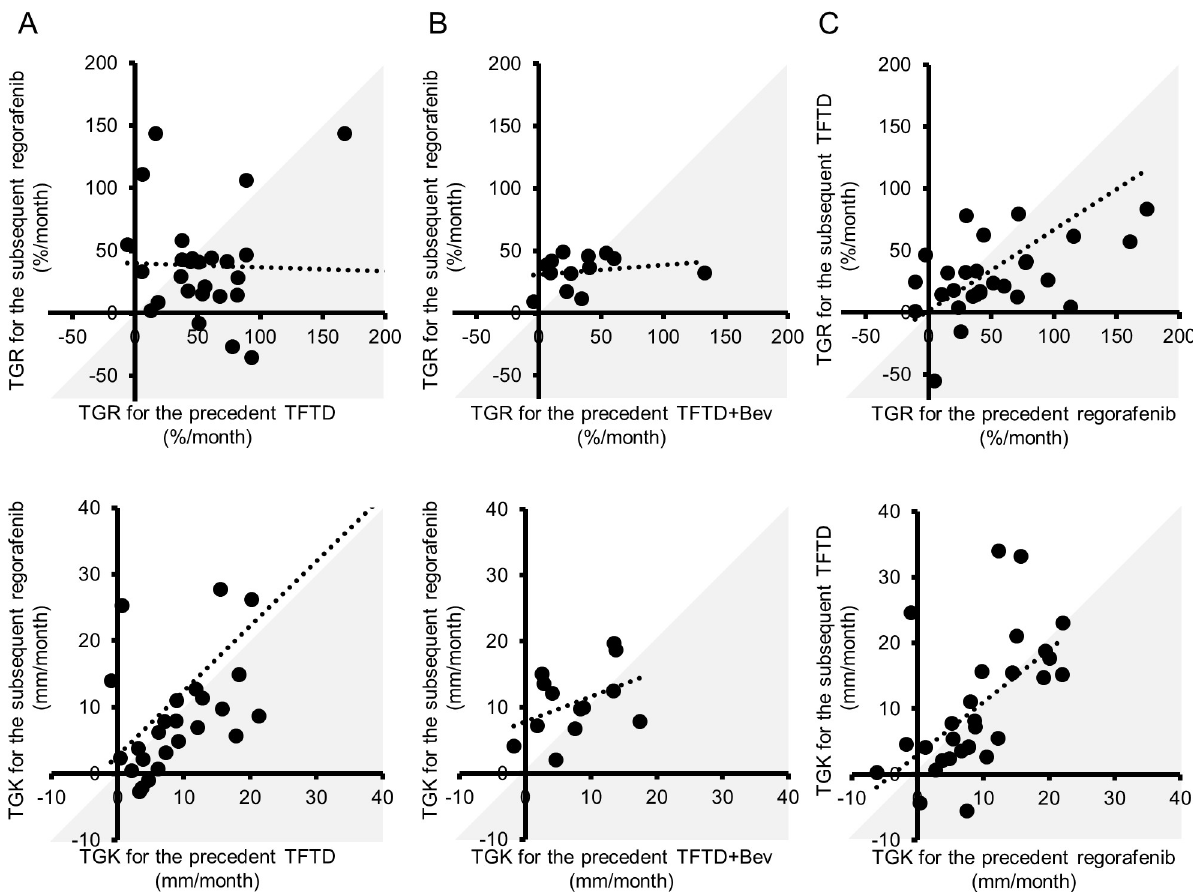
Fig 4. Distribution of the tumor growth rate and tumor growth kinetics in each pair of the precedent and subsequent agents. Distribution of the tumor growth rate (TGR) in the (A) TFTD ! Rego group, (B) TFTD+Bev ! Rego group, and (C) Rego ! TFTD group; distribution of the tumor growth kinetics (TGK) in the (D) TFTD ! Rego group, (E) TFTD+Bev ! Rego group, and (F) Rego ! TFTD group. The grey area indicates decrease in the TGR and TGF during the subsequent therapy as compared to the precedent therapy. Dot plot shows correlation between each pair of the TGR or TGK of the precedent agents and subsequent